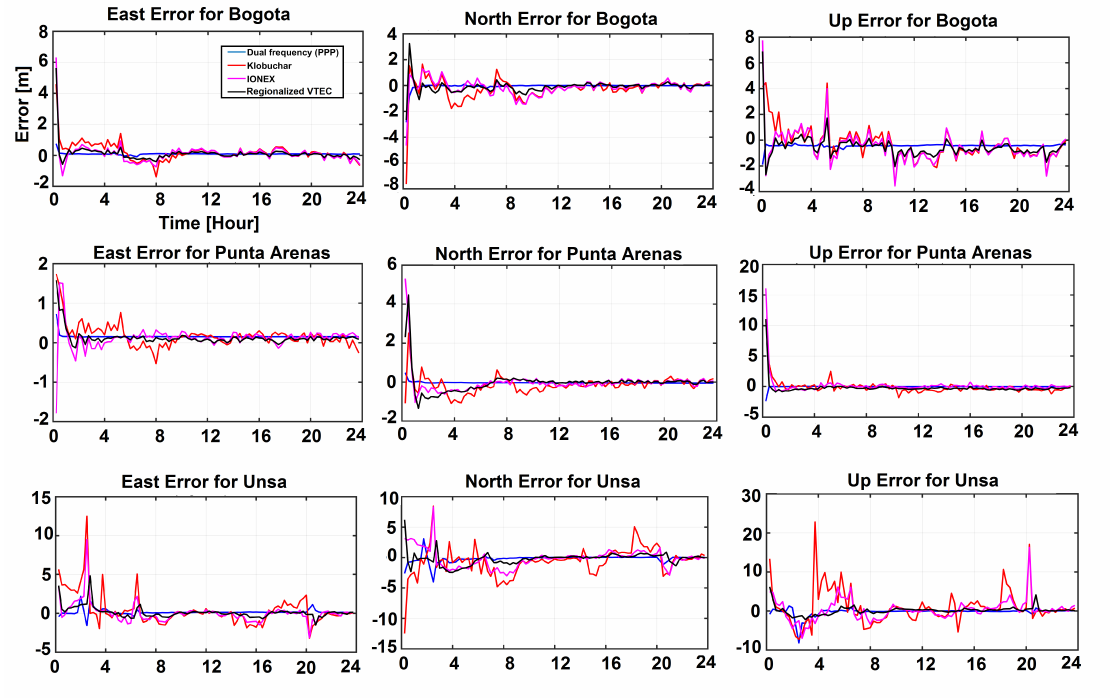
Figure 9. Position errors in the local east, north and height direction for Bogota (lat = 4.64007 and lon = 285.91906 in Columbia), Punta Arenas (lat = − 53.13695 and lon = 289.12011 in Chile) and Unsa (lat =